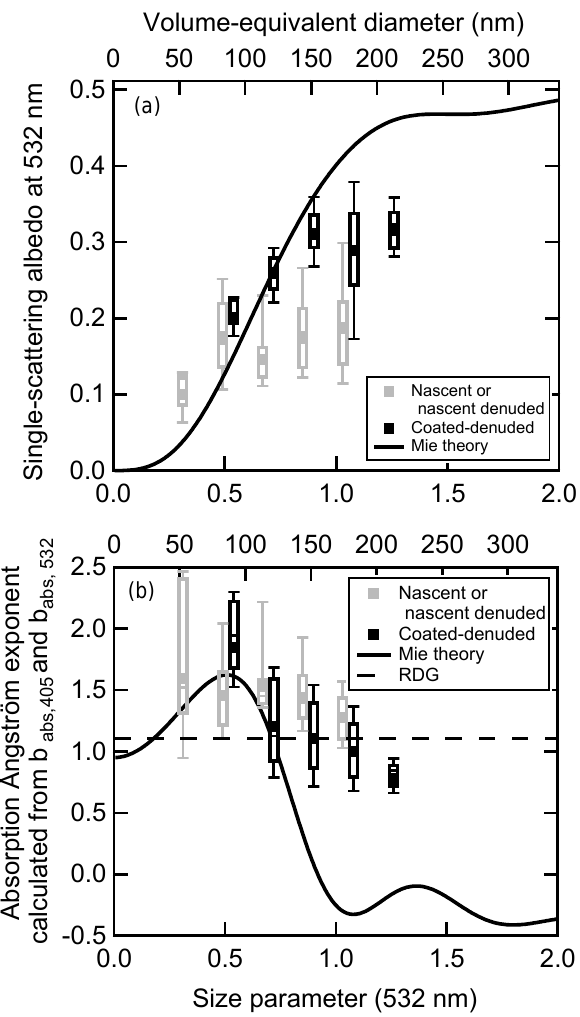
Figure 4. Box and whisker plots of λ = 532nm (a) single-scattering albedo (SSA) and (b) absorption Ångström exponent (AAE) as a function of volume-equivalent diameter produced from the methane diffusion flame. The black points are coated–denuded data (coat- ing material is evaporated following coating with DOS or sulfu- ric acid) and are potentially collapsed due to coating, and the gray points are nascent or nascent–denuded data. The black lines are the SSA or AAE predicted by spherical particle Mie theory, and the dashed black line in (b) is AAE predicted from the RDG approxi- mation using the effective refractive indices listed in Table 1. The nascent or nascent–denuded boxes (black) are shifted by X = 0 . 05. Points in each bin range from N = 6 at x 0 . 36 to N = 26 at x 1 . 08 for nascent (or nascent–denuded) and N = 5 at x 0 . 54 to N = 9 at x 1 . 26 for coated–denuded